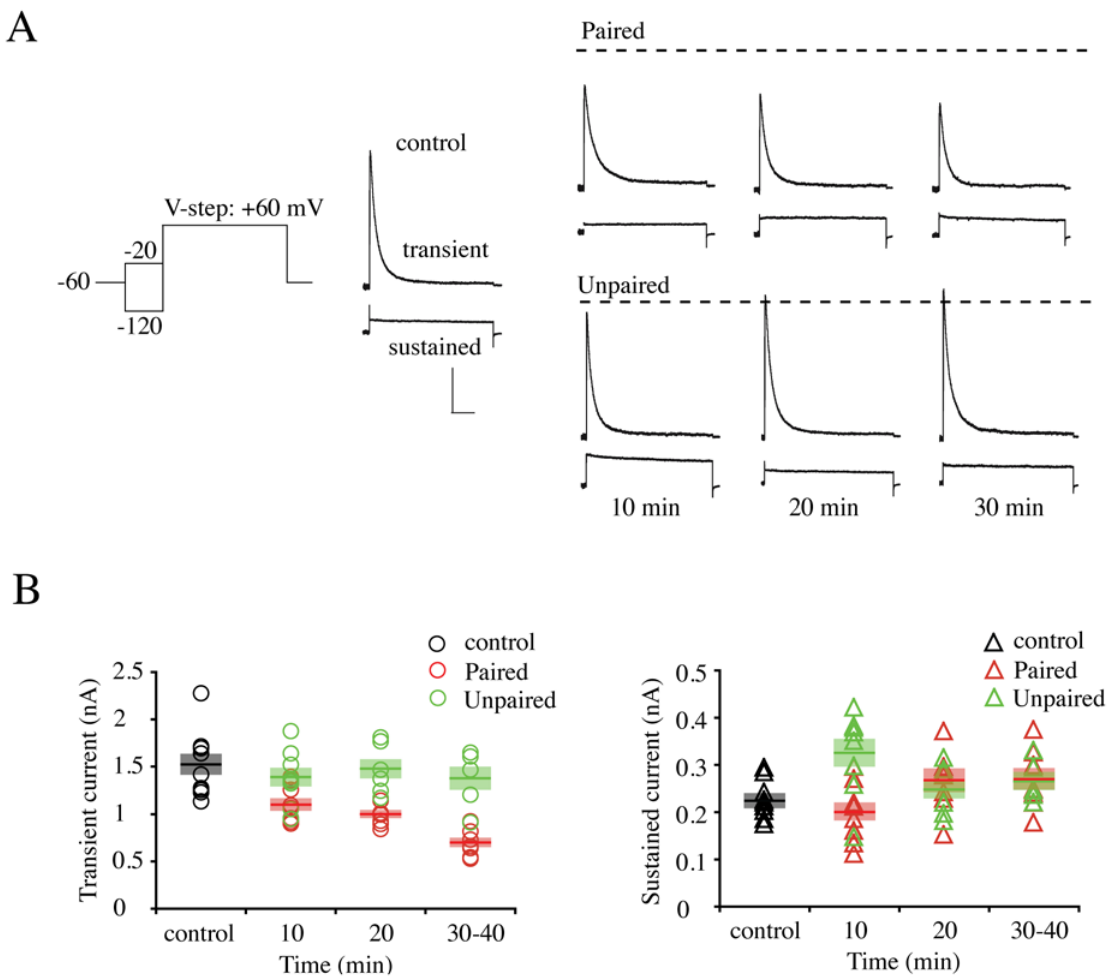
Figure 4. Synaptic LTP decreases peak A-current density. A . Total A-current was acquired by subtracting the sustained current (obtained using a prepulse to inactivate I A as shown in the voltage protocol) from total current. Each trace is an average of three sweeps. In paired neurons showing potentiation of synaptic transmission, peak I A progressively decreased with time after LTP induction. Dashed line indicates control amplitude. Scale bars 500 pA, 100 ms. B . Summarized changes of peak amplitude of transient (left panel) and sustained (right panel)